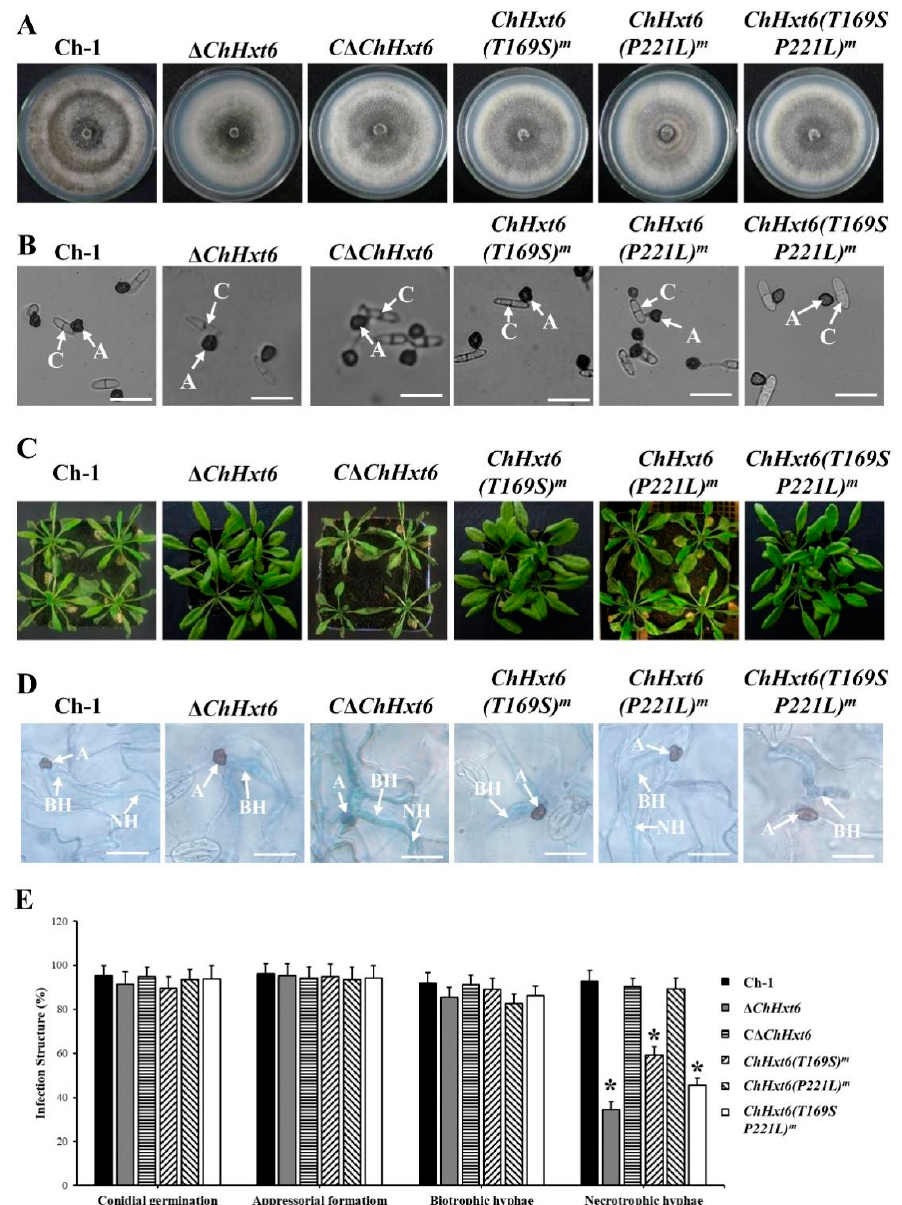
Figure 6. Virulence tests of ChHxt6 site-directed mutants. ( A ) Colony morphology of the wild-type, ChHxt6 knockout mutants, complementation strain and mutants from site-directed mutagenesis. All strains were cultured for 7 days on PDA plates in darkness at 25 °C. ( B ) Conidial germination of ChHxt6 mutants derived from site-directed mutagenesis. Conidia of the strains were cultured on plastic coverslips for 24 h, and germination of conidia was observed under microscope. A: appressoria; C: conidia. Bar = 15 μ m. ( C ) Virulence tests of ChHxt6 mutants. ( D ) The infection structures generated at 48 h post incubation. The Arabidopsis leaves inoculated by conidia of wild type and mutants were collected at 48 h post inoculation. Infection structures were observed under microscope. Inoculated leaves were treated with methanol: chloroform: glacial acetic acid (6:3:1, v / v / v ) and stained with trypan blue (0.4%). A: appressoria; BH: biotrohic hyphae; NH: necrotrophic hyphae. Bar = 20 μ m. ( E ) Generation rate of infection structures. To calculate infection structure generation rate, at least 100 infection structure were observed, and each test was repeated three times. Bars show means and standard deviations of generation rates of infection structures, respectively. Asterisks represent significant differences between the Ch-1 and other strains by LSD test at p =